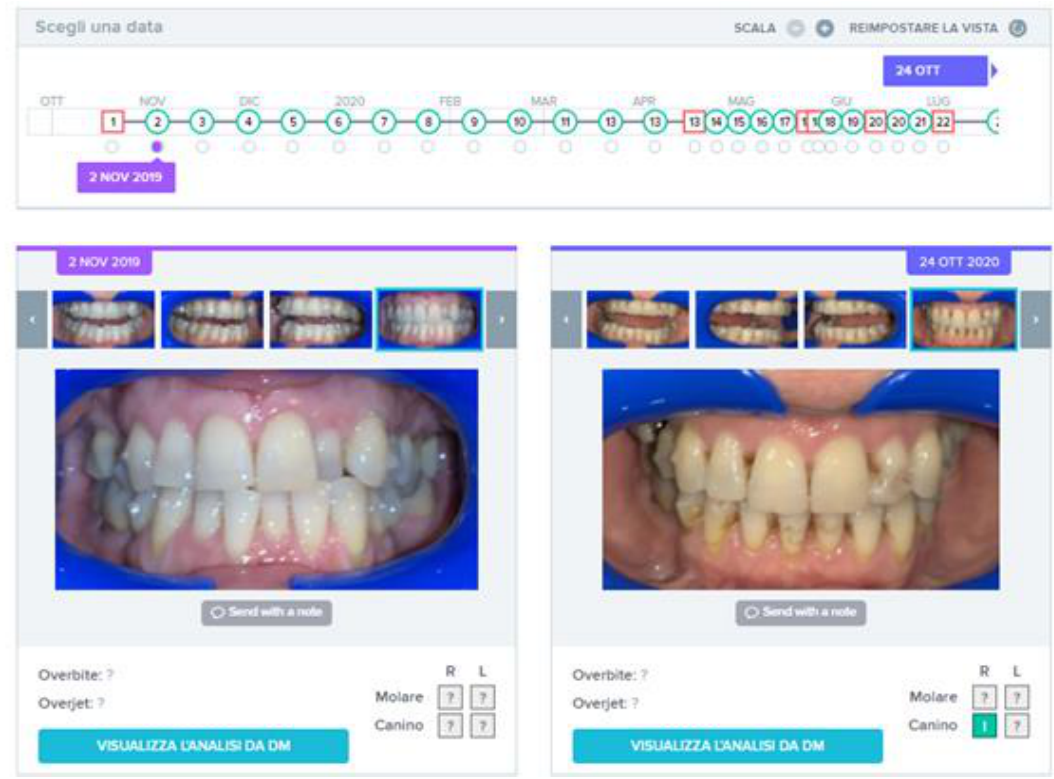
Figure 11. Sequence of monitoring over time for Case 1, with Go signals in green and No Go signals in red. At the end of the period, after 12 months of treatment, the tooth 2.2 is perfectly aligned.